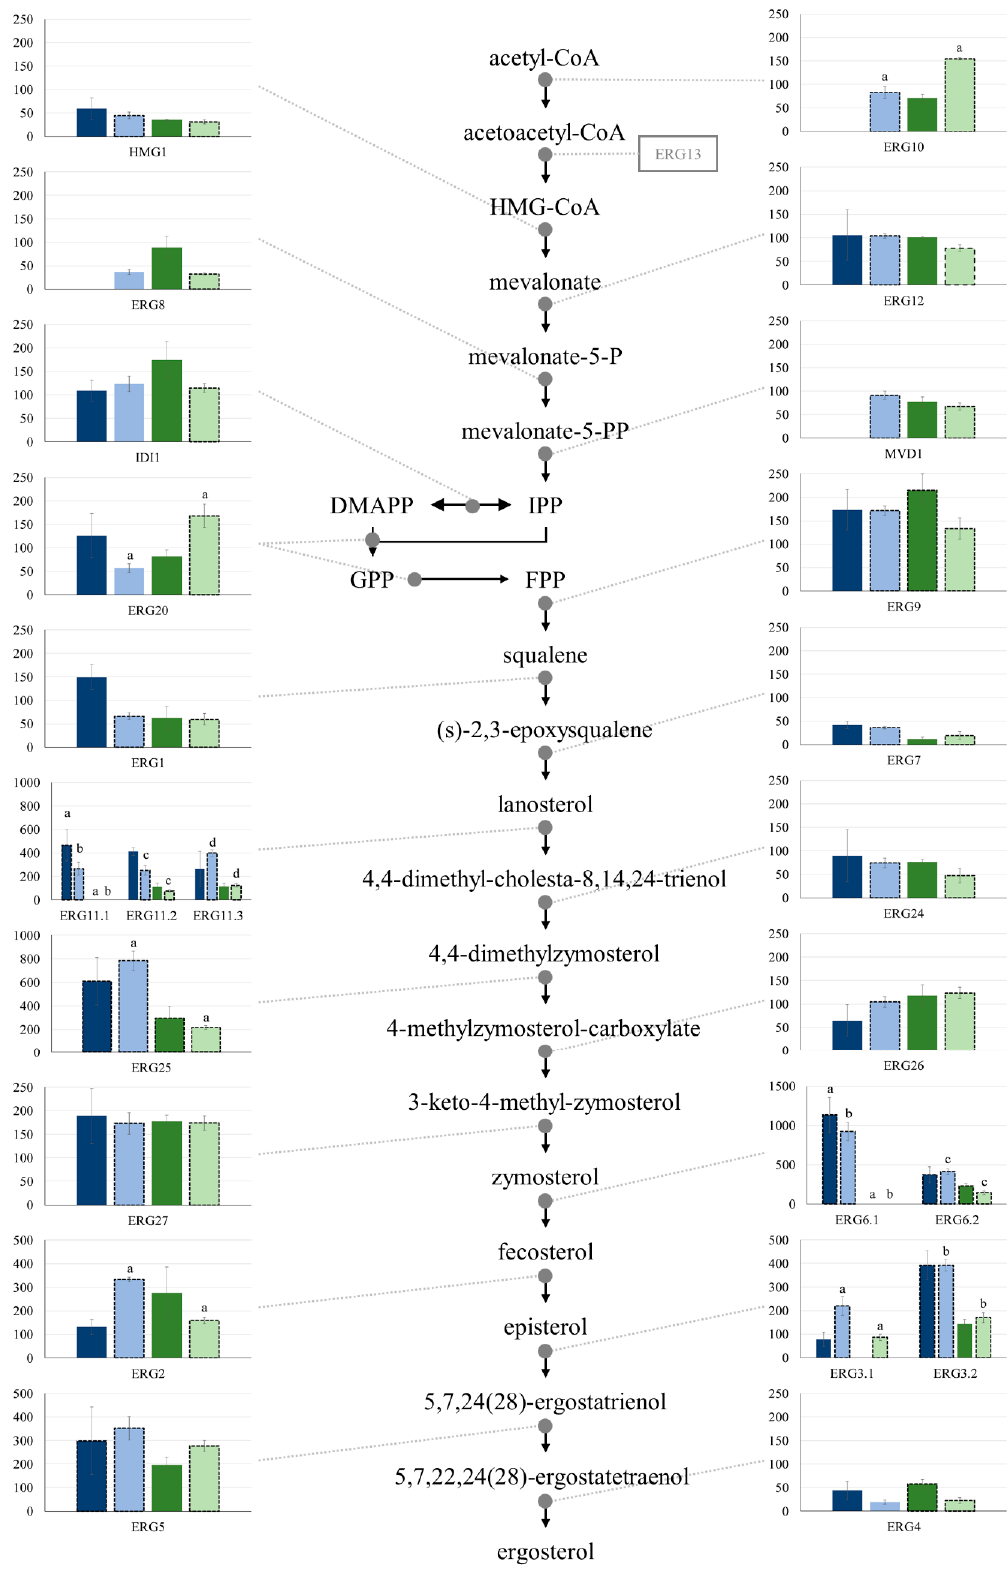
Figure 1. Expression of Fusarium circinatum ergosterol biosynthesis genes during infection. The y-axes represent average FPKM across biological replicates for inoculated samples from P. patula (blue) and P. tecunumanii (green) at 3- (dark colours) and 7- (light colours) dpi. Error bars represent the standard